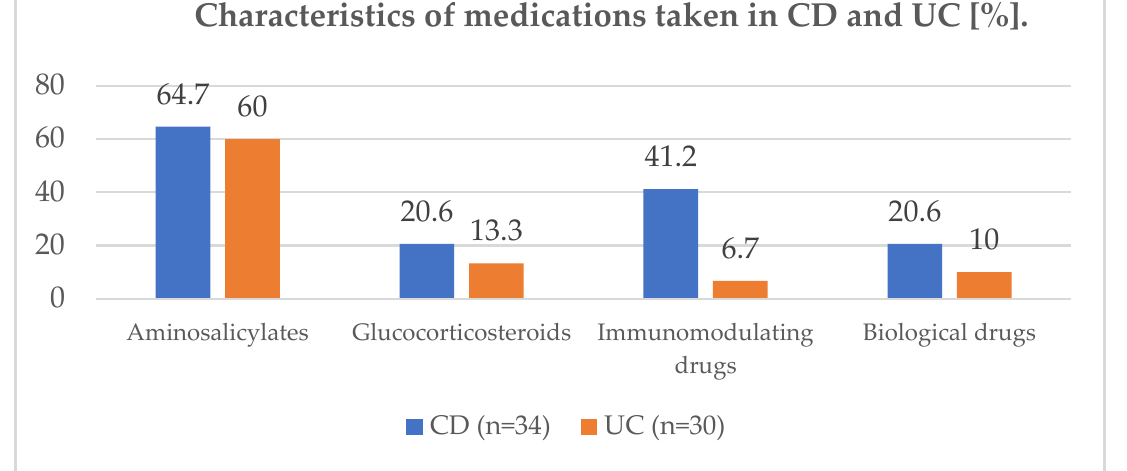
Figure 2. Characteristics of medications taken in CD and UC (%). CD—Crohn’s disease, UC— ulcerative colitis.